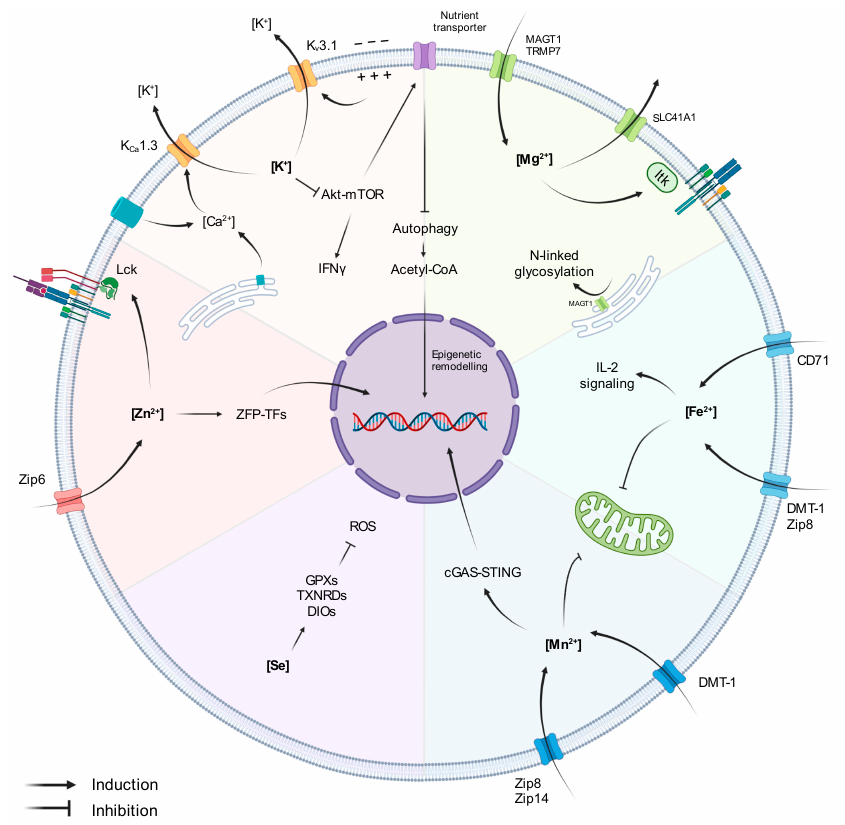
Figure 1. Influence of Ions on T-cell activity.